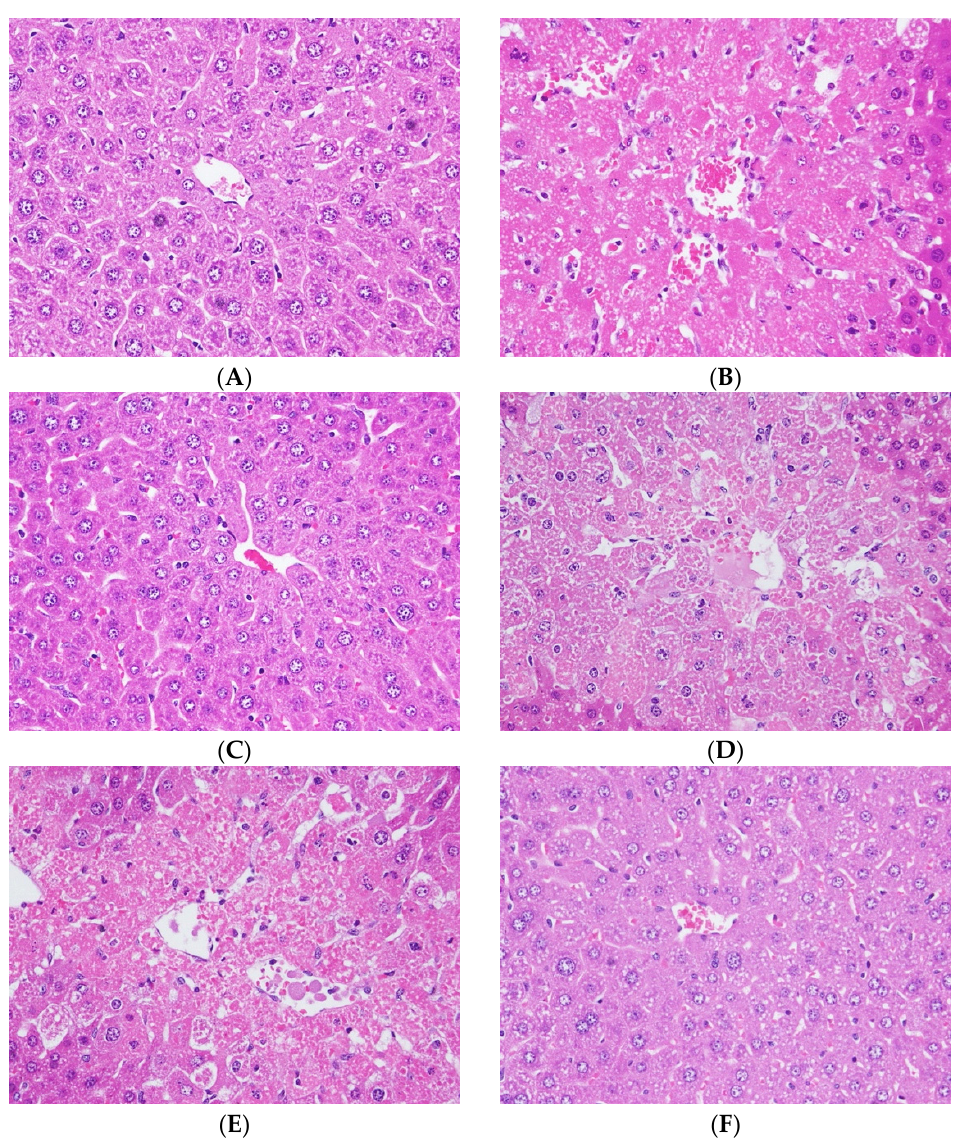
Figure 2. The morphological analysis of hepatoprotective effect of the CGA in CCl 4 -intoxicated mice. Dissected liver tissues were stained with haematoxylin–eosin by standard techniques (400×). ( A ) Normal control; ( B ) CCl 4 control; ( C ) silymarin (200 mg/kg) + CCl 4 ; ( D ) CGA (60 mg/kg) + CCl 4 ; ( E ) CGA (100 mg/kg) + CCl 4 ; and ( F ) CGA (200 mg/kg) + CCl 4 .